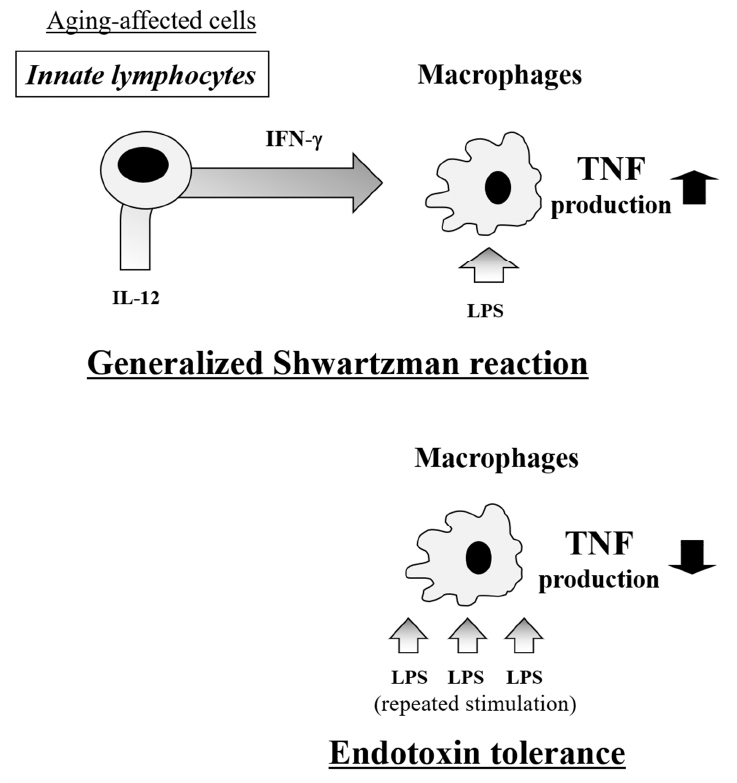
Figure 7. Immune mechanisms in the generalized Shwartzman reaction and endotoxin tolerance. In the generalized Shwartzman reaction, innate lymphocytes, which are age-a ff ected cells, are closely involved in the priming phase to stimulate macrophages, leading to an enhanced TNF